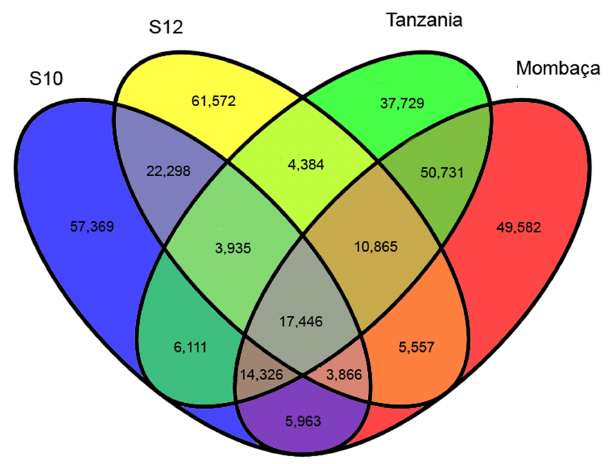
Figure 4. Shared and unique putative SNPs found in Panicum maximum unigenes.